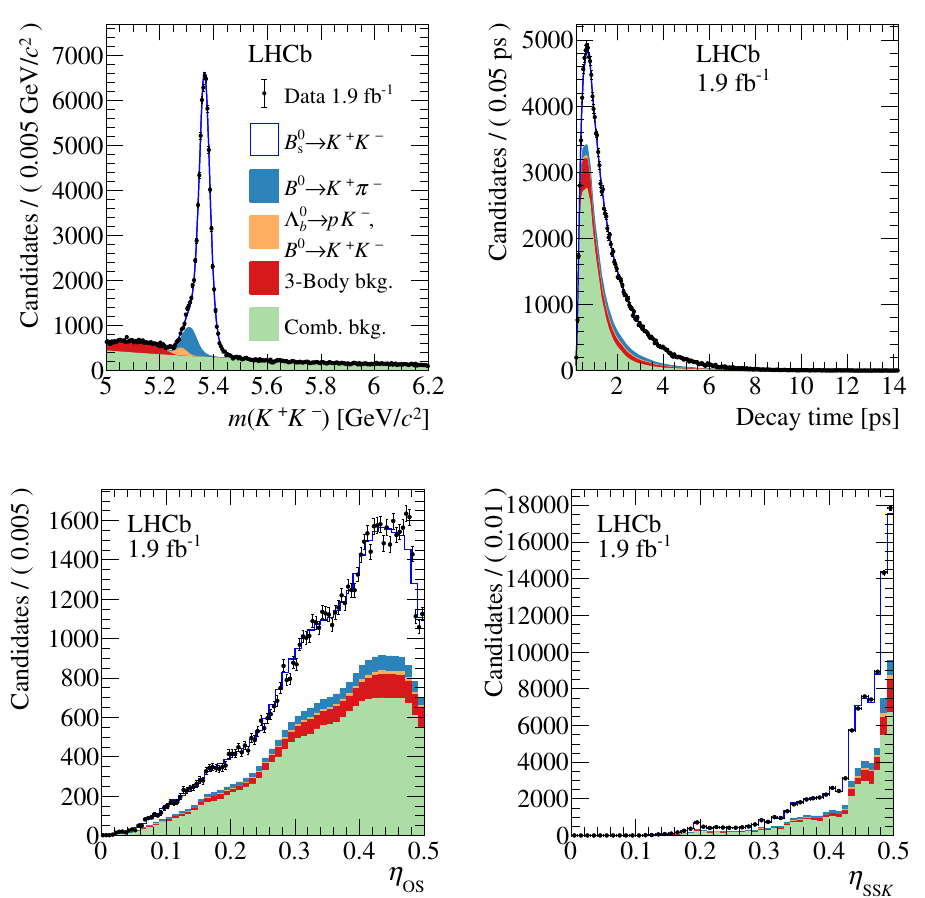
decay time, mistag ( s )